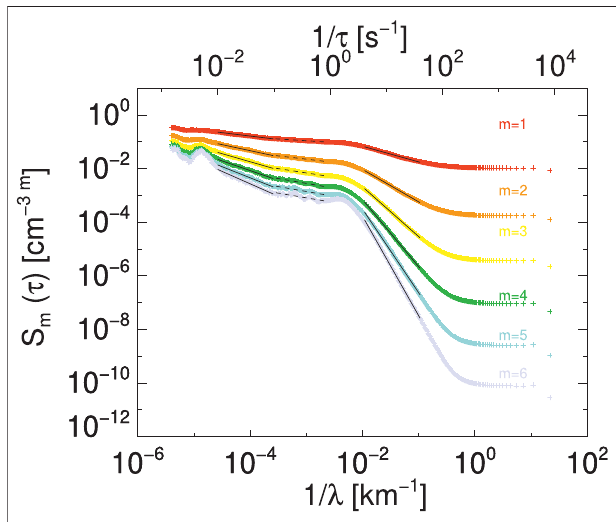
FIGURE 6 | The m -th order structure functions for m (cid:2) 1 to m (cid:2) 6. The straight lines denote fi ts over three different time lag ranges the inertial scales 1 τ (cid:2) [ 0 . 01 , 0 . 1 ] s − 1 the transition scales 1 τ (cid:2) [ 0 . 1 , 0 . 8 ] s − 1 and the sub-ion range 1 τ (cid:2) [ 4 , 40 ] s − 1